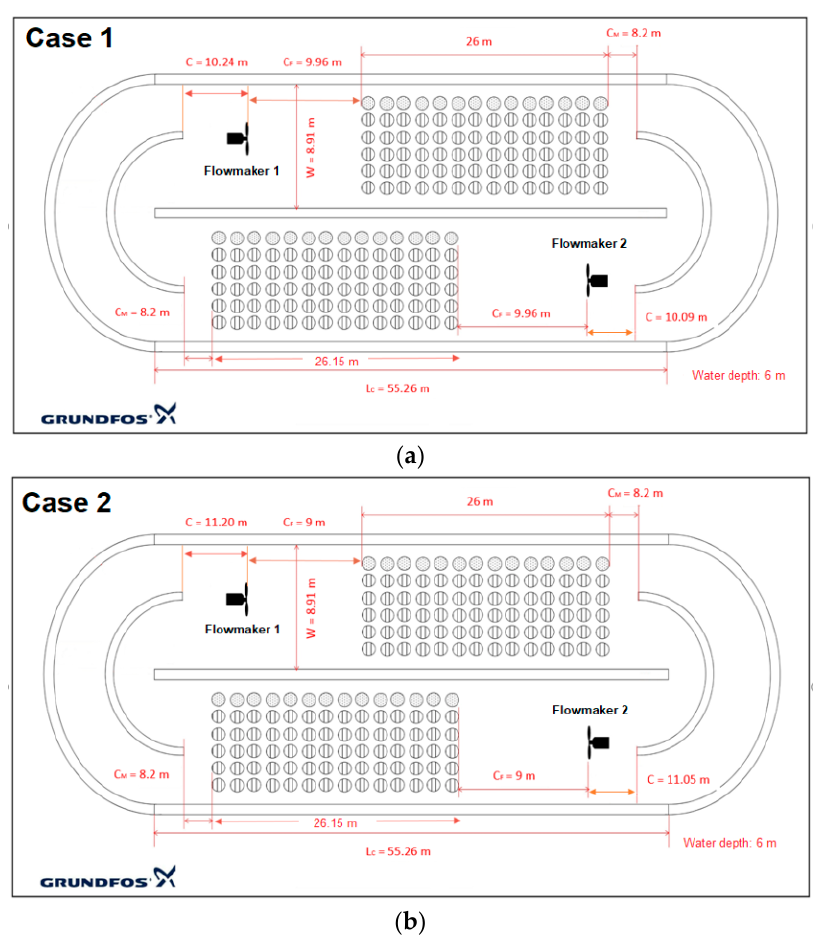
Figure 11. Oxidation ditch plan for Case 1 ( a ) and Case 2 ( b ).